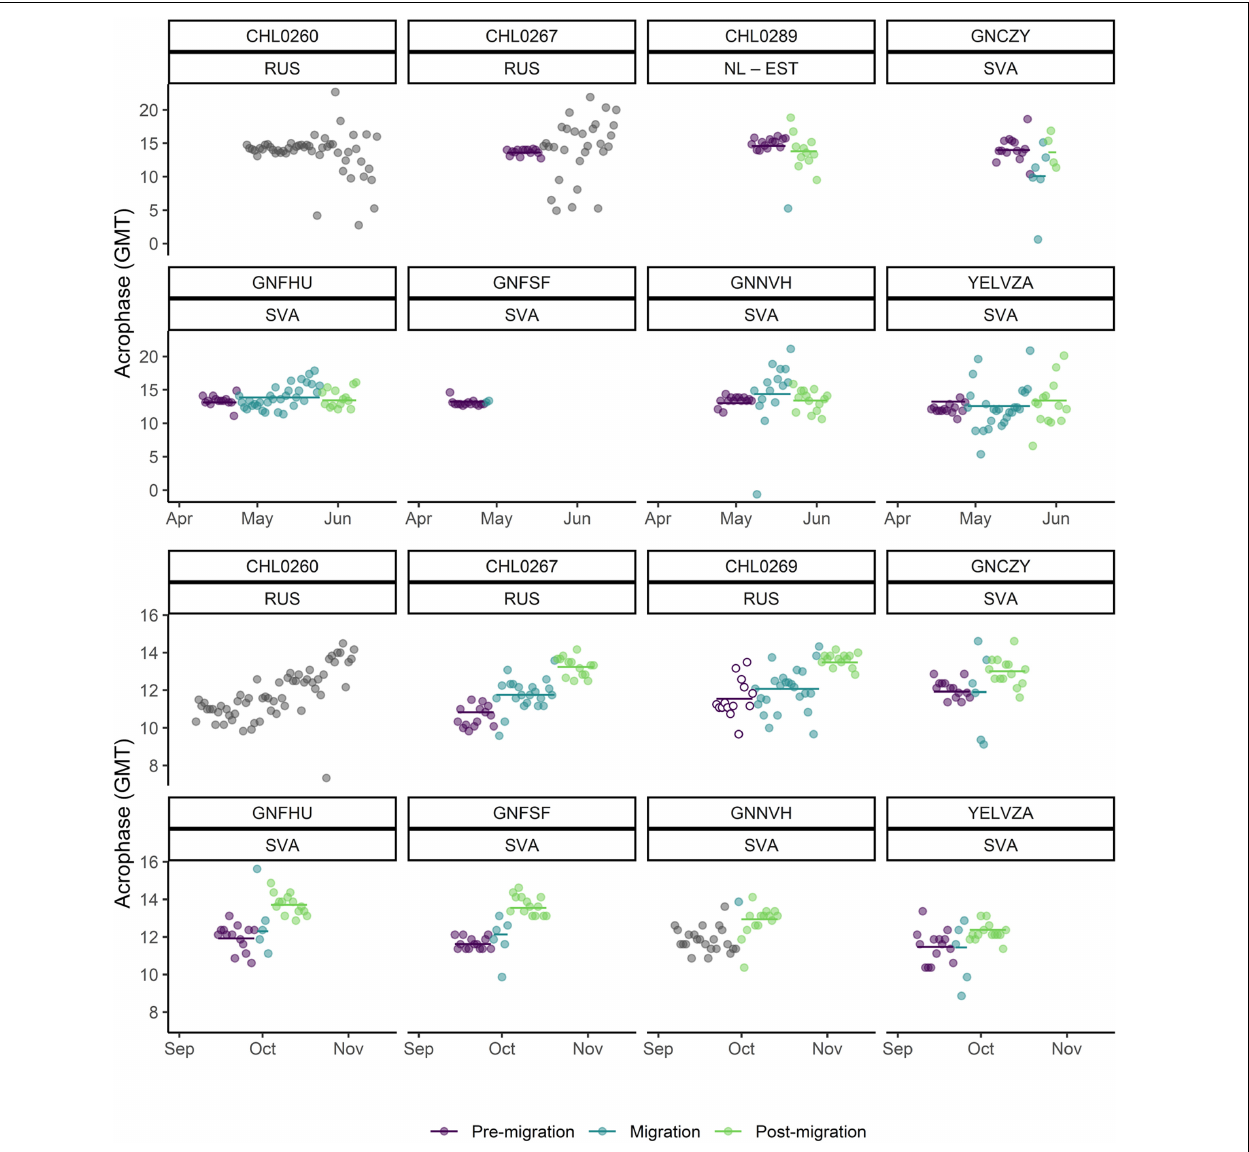
FIGURE 2 | Daily acrophase of individual Tb rhythms over spring and autumn in barnacle geese from the Svalbard (SVA) and Russian (RUS) populations (individual ID is given on top of each plot). Included is also goose CHL0289 from the Netherlands population (NL) that migrated to Estonia (EST) in the Baltic in spring. The migration period was determined from heart rate (SVA) or GPS locations (RUS, NL), and the 14 days immediately preceding and following migration are plotted as the pre-and post-migratory periods. Data from days where the migratory stage of the bird could not be inferred from either heart rate or GPS are plotted in grey. Open circles in the panel for CHL0269 refer to a period when the bird was located at a staging site (Kanin Peninsula) southwest of the breeding site. Model fits from linear mixed effects analysis of acrophase during each stage of migration are shown as horizontal